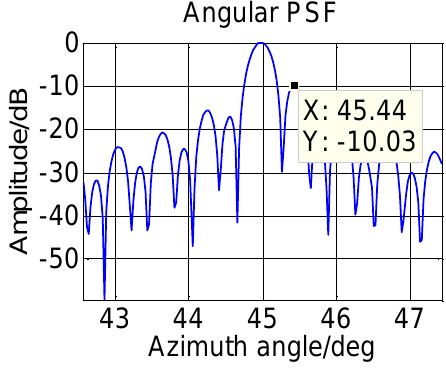
Figure 14. Angular PSF of edge point.